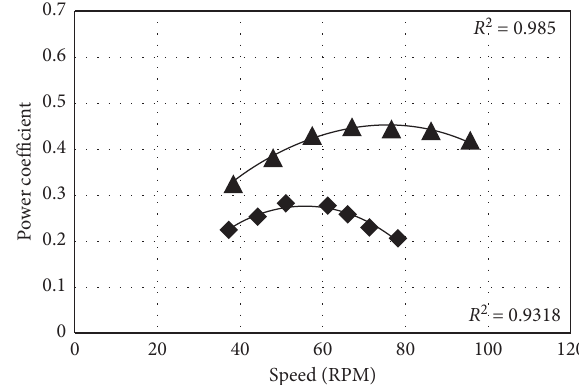
Figure 20: Runner 3 data